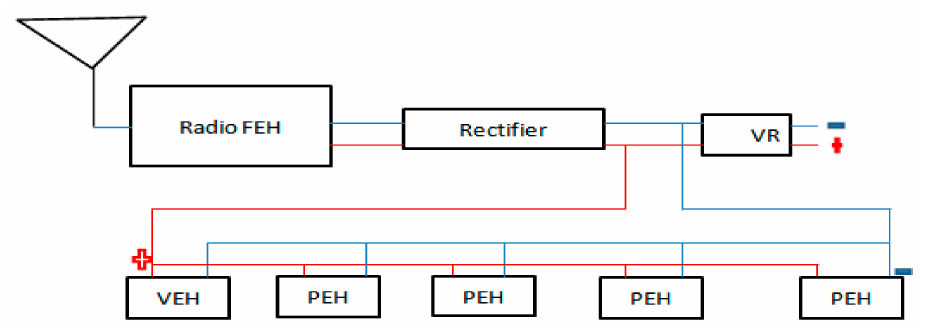
Figure 7. Basic RF energy harvesting system.